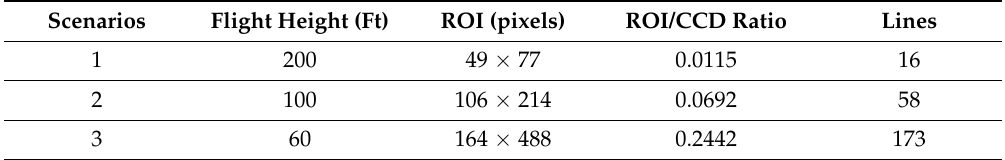
Table 2. The statistics of the runway detection at three typical flight